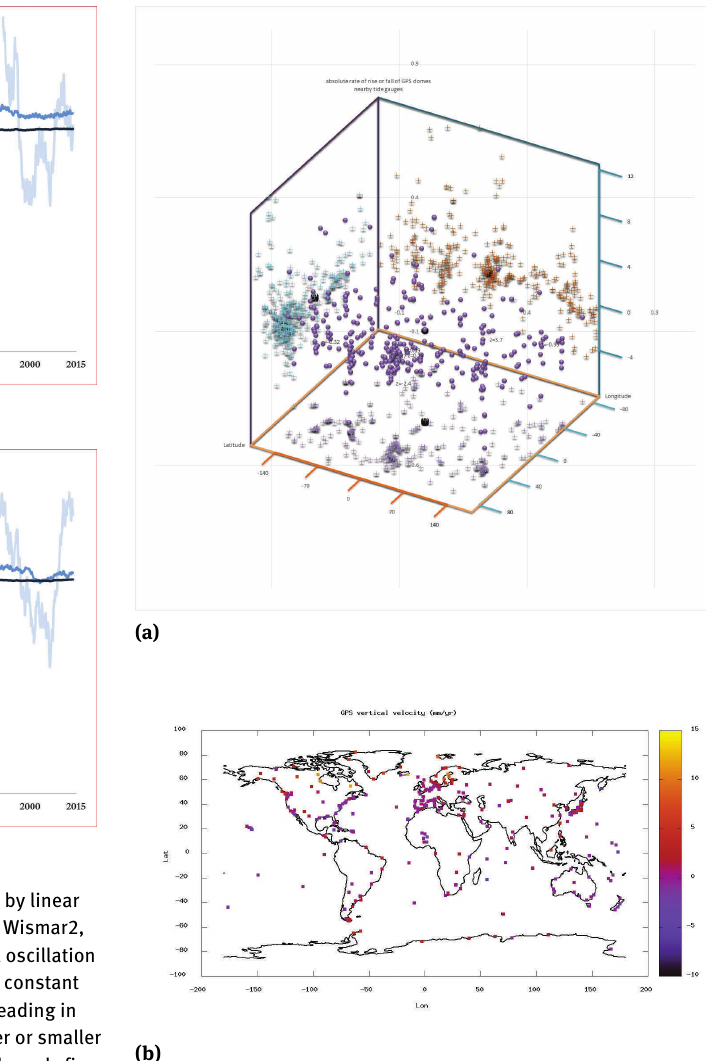
Fig. 6: Uplift velocities of SONEL GPS domes in mm/year vs. latitude and longitude in degrees. a) latitude-longitude-vertical velocity space. b) GPS dome location in the world map. The 326 GPS domes have uplift velocities ranging from + 12.47 to − 8.00 mm/year, with an average of + 0.44 mm/year. The accuracy of this result is much larger than the ±0.36 mm/year only accounting for the fitting in- accuracy and very likely about ±2 mm/year. The vertical velocity of inland GPS domes is not the vertical velocity of a nearby tide gauge that may suffer more subsidence for example for compaction.